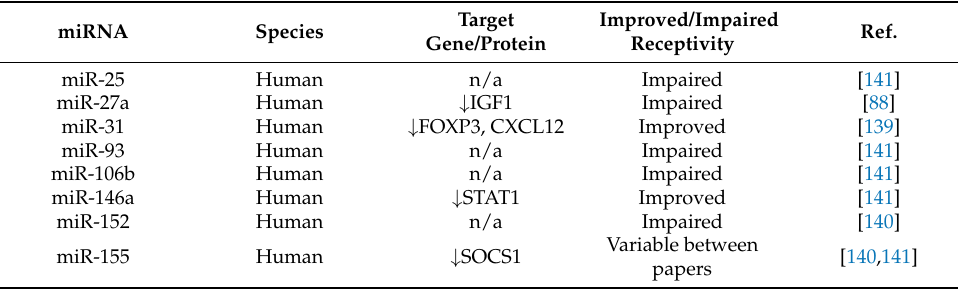
Table 4. miRNAs identified as potential serum